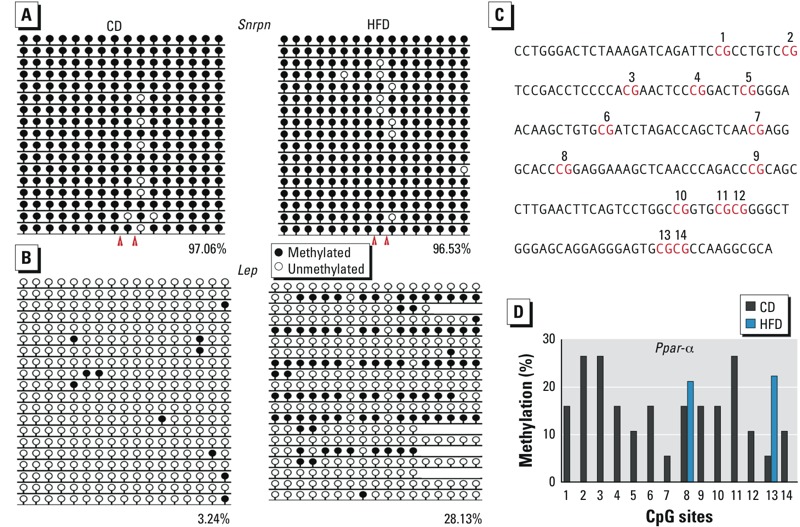
DNA methylation status of Snrpn, Lep, and Ppar-α in oocytes from CD and HFD dams as analyzed by bisulfite sequencing. Oocytes from 10 mice were used per analysis. (A) DNA methylation level of Snrpn (A; red arrowheads indicate the recognition sites of BstUI), and Lep (B; analyzed region located at chr6: 26009934..26010283). Numbers indicate the percentage of methylation; blank loci indicate lost CpG. (C) Distribution of some CpG sites in the Ppar-α promoter in the analyzed region; CpG sites are numbered 1–14. (D) Percentage of DNA methylation at the 14 CpG sites in the Ppar-α promoter (C).